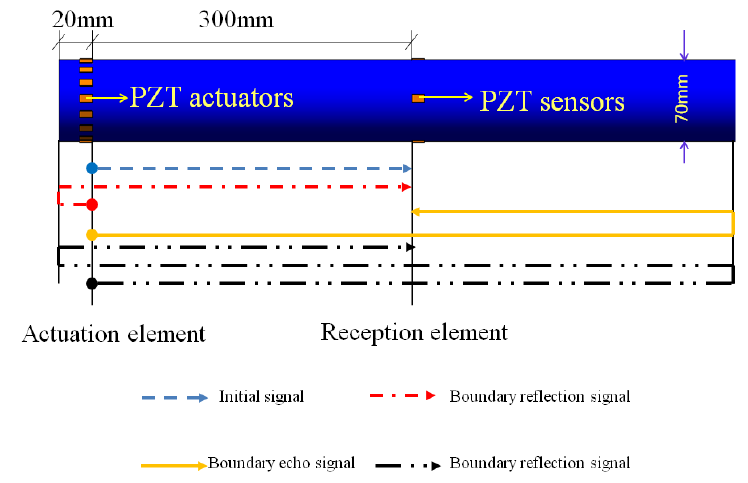
Figure 9. The new layout of the transducers and the schematic of signal propagation in the pipe in the simulation.